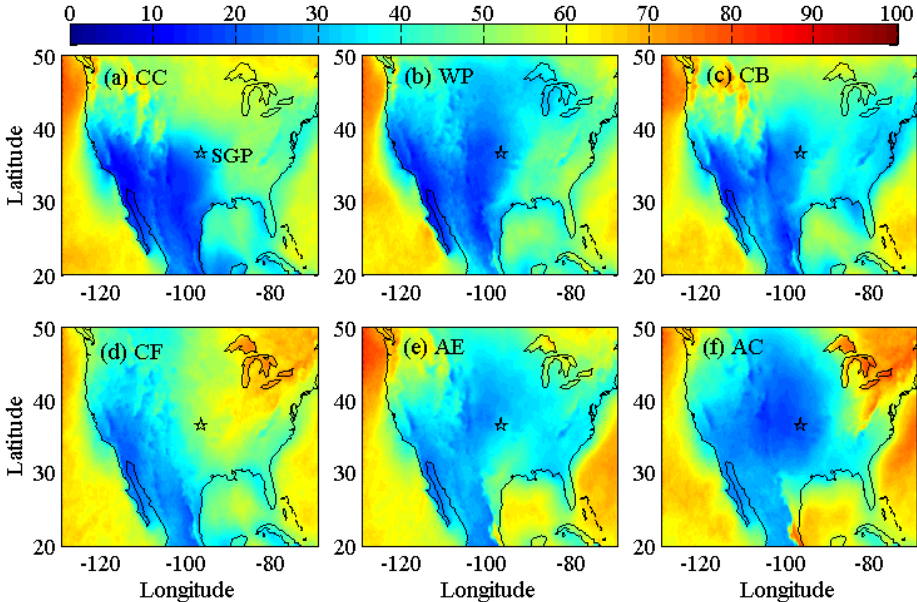
Figure 4. Total cloud cover (%) derived from the daily NCEP NARR product averaged over 2001 to 2010 in the synoptic patterns of: CC ( a ); WP ( b ); CB ( c ); CF ( d ); AE ( e ); and AC ( f ) over the SGP site. The black star in each panel denotes the location of the SGP site.